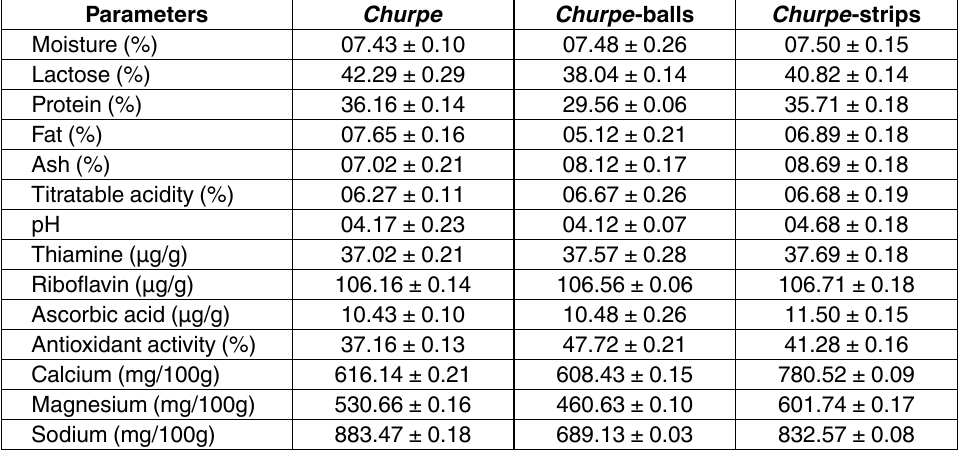
Table 1. Nutritional composition of churpe and value added churpe products Parameters